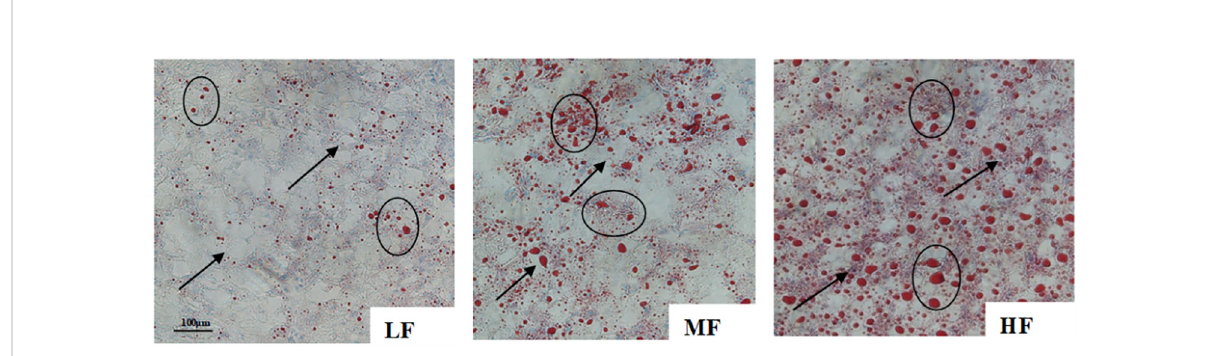
FIGURE 1 Effect of dietary lipid levels on hepatic histology of hybrid grouper (oil-red × 400; The lipid deposition status is shown by arrows and ovals).